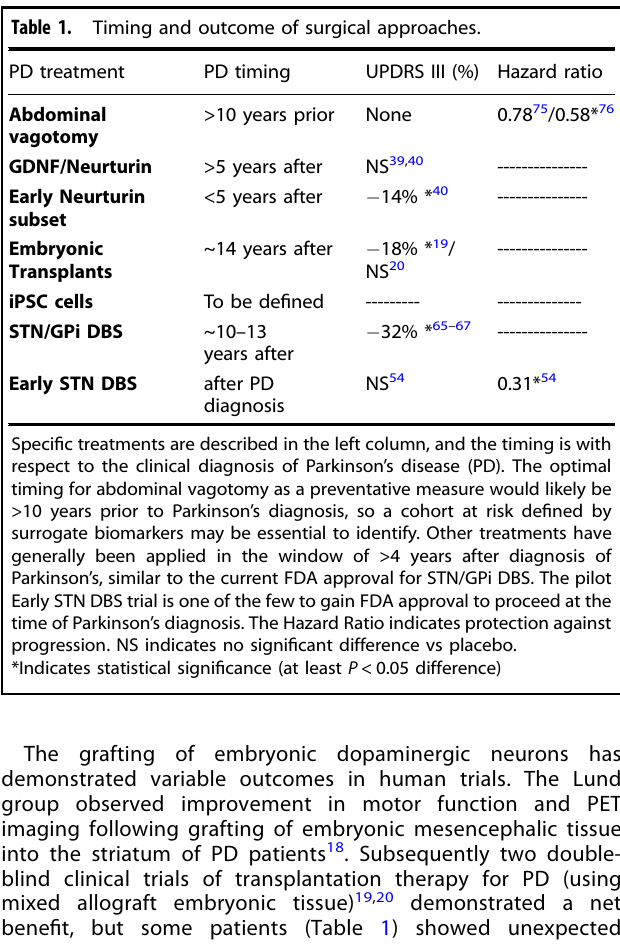
The grafting of embryonic dopaminergic neurons has demonstrated variable outcomes in human trials. The Lund group observed improvement in motor function and PET imaging following grafting of embryonic mesencephalic tissue into the striatum of PD patients 18 . Subsequently two double- blind clinical trials of transplantation therapy for PD (using mixed allograft embryonic tissue) 19,20 demonstrated a net